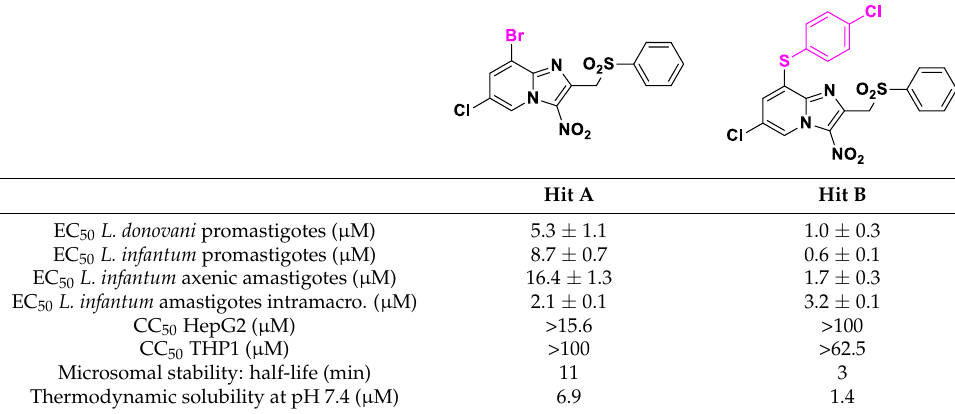
Figure 1. Structures of nitroheterocyclic drug-compounds that are substrates of the parasitic type 1 nitroreductases.